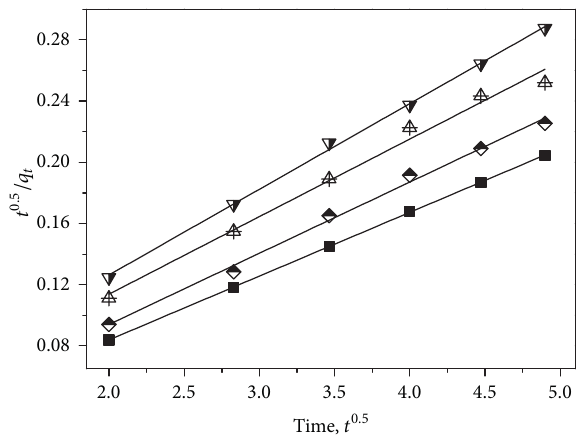
Figure 5: Diffusion-chemisorption model for the adsorption of strontium ions on samples A (solid square), B (half-filled diamond), C (center up triangle), and D (half-filled down